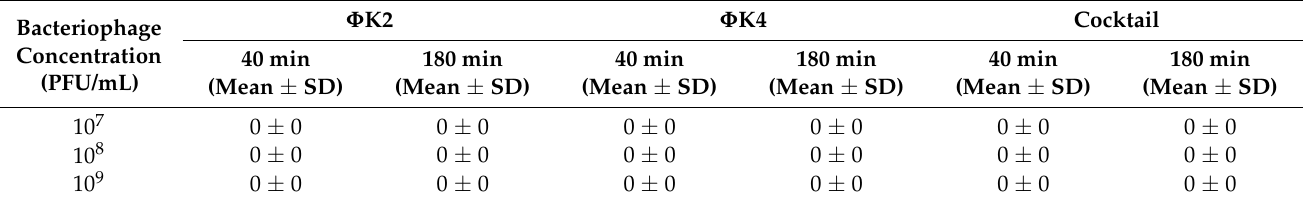
Table 3. Determination of minimal concentration and washing time of bacteriophage.